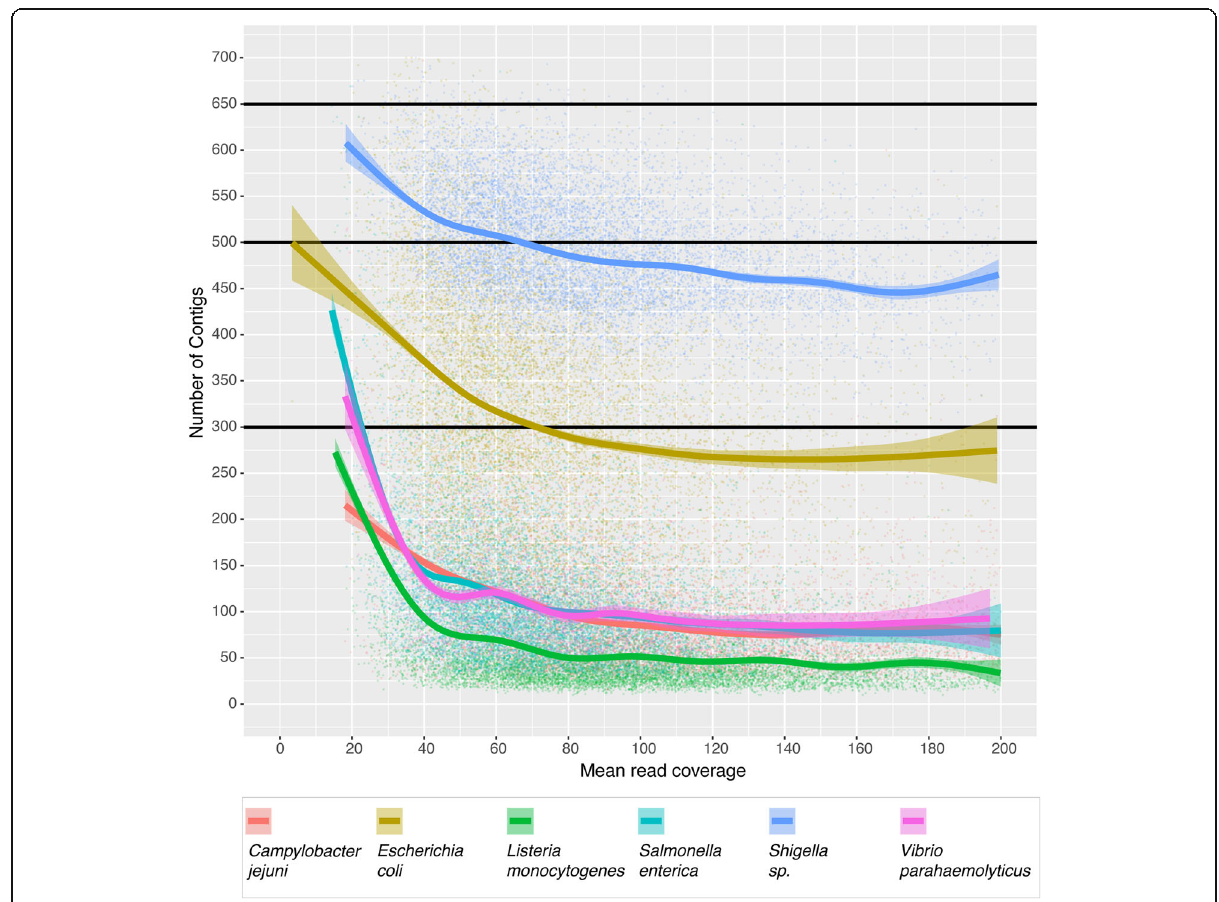
Fig. 4 Plot of mean coverage (as reported by SKESA v. 2.2) vs number of contigs for a random sample of isolates with Illumina sequence data available from NCBI Pathogen Detection portal (n = 10,000 for all species except V. parahaemolyticus where n = 1414 due to smaller number of samples). The smoothed line was generated using generalized additive smoothing in R. Assembly quality, as measured by a decrease in